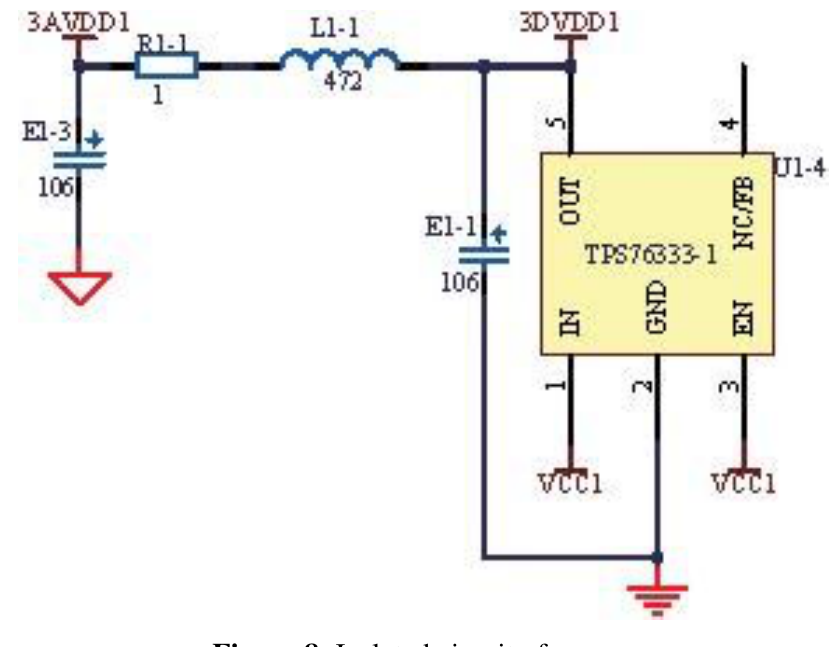
Figure 8. Isolated circuit of power.